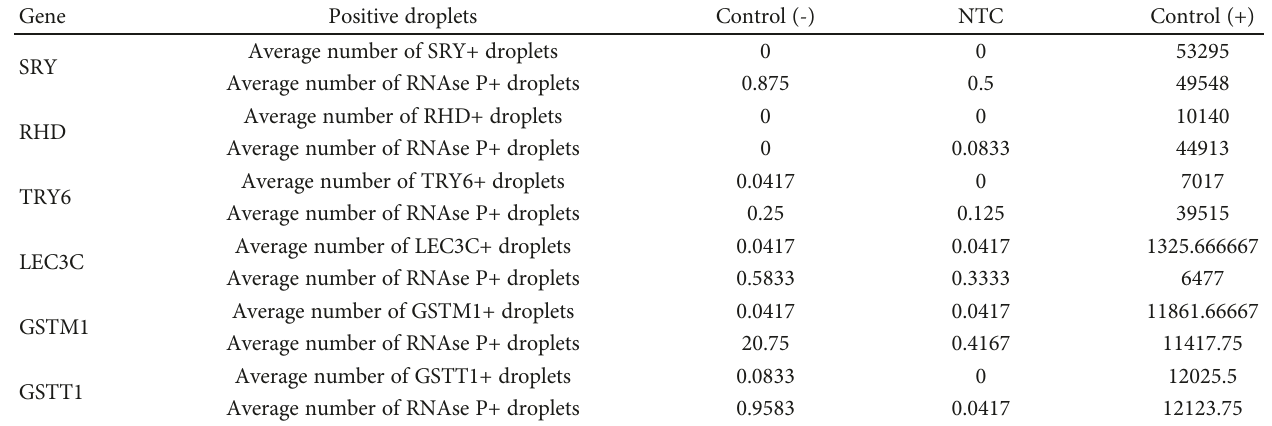
Table 5: Speci fi city.